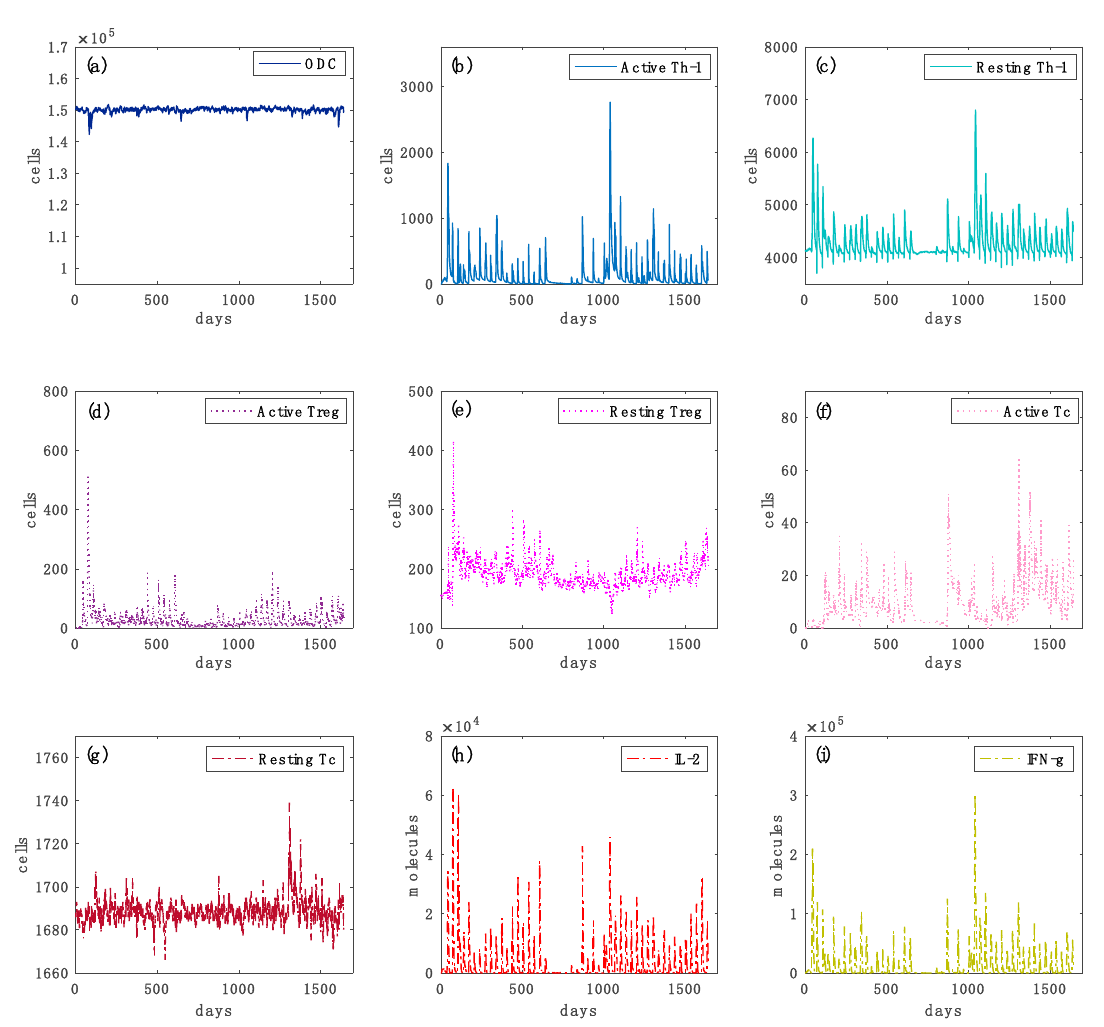
Figure 4. Simulated oligodendrocyte (ODC), Active T helper cells (Active Th-1), Resting T helper cells (Resting Th-1), Active regulatory T cells (Active Treg), Resting regulatory T cells (Resting Treg), Active cytotoxic T cells (Active Tc), Resting cytotoxic T cells (Resting Tc) populations, inflammatory cytokines Interleukin-2 (IL-2) and Interferon-gamma (IFN-g) dynamics for the virtual healthy control patient are respectively depicted in panels ( a – i ), respectively. In Figure 4, panel ( a ), the variations in the levels of oligodendrocytes are relatively smaller in healthy controls than those of the diseased cases (Figure 5, panel ( a )). In panels ( b , c ), Th-1 cell populations that could be potentially dangerous in inducing an auto-reactive immune response against oligodendrocyte are kept under control by the regulatory T cells activity. In panels ( d , e ), the activation of regulatory T cells and their consequent activity in suppressing any auto-reactive immune response is noticeably increased. In panels ( f , g ), active cytotoxic T cells levels are almost inexistent. In panels ( h , i ), interleukin 2 (IL-2) and inflammatory interferon gamma (IFN-G) cytokines do not show su ffi cient levels to induce any inflammatory